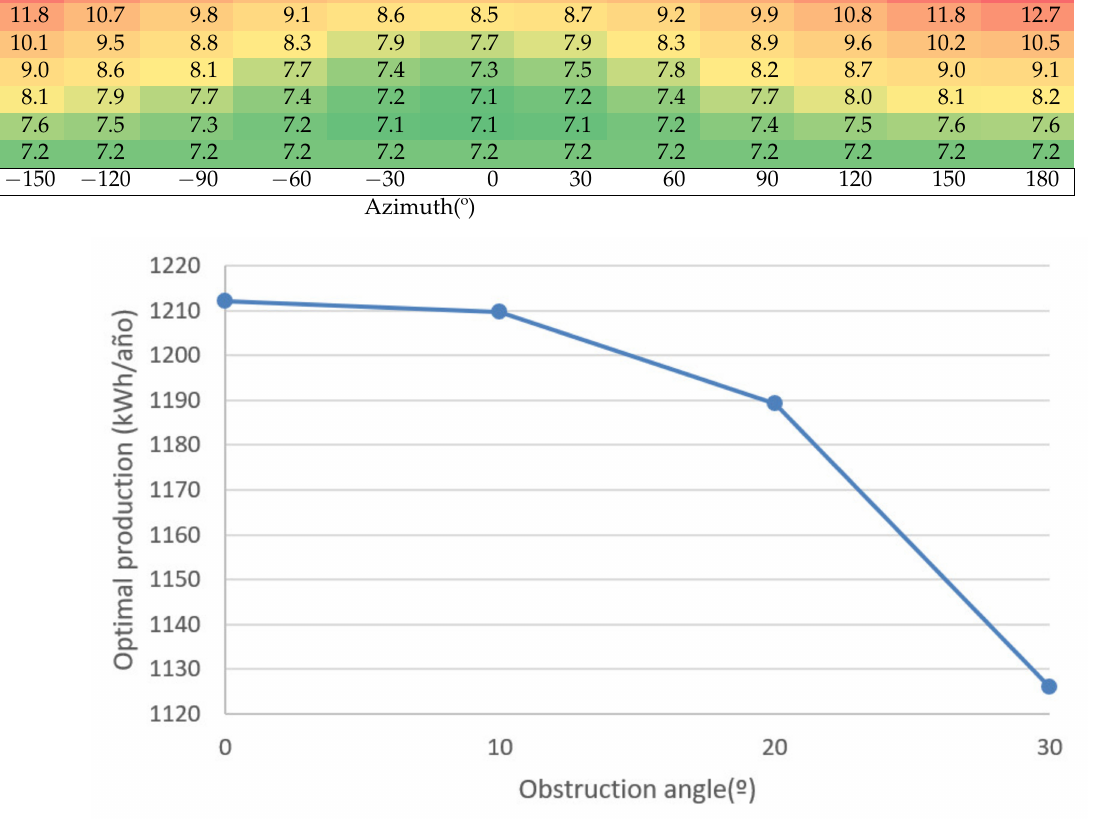
Figure 6. Optimal production reduction in a 1000 Wp plant depending on the degree of